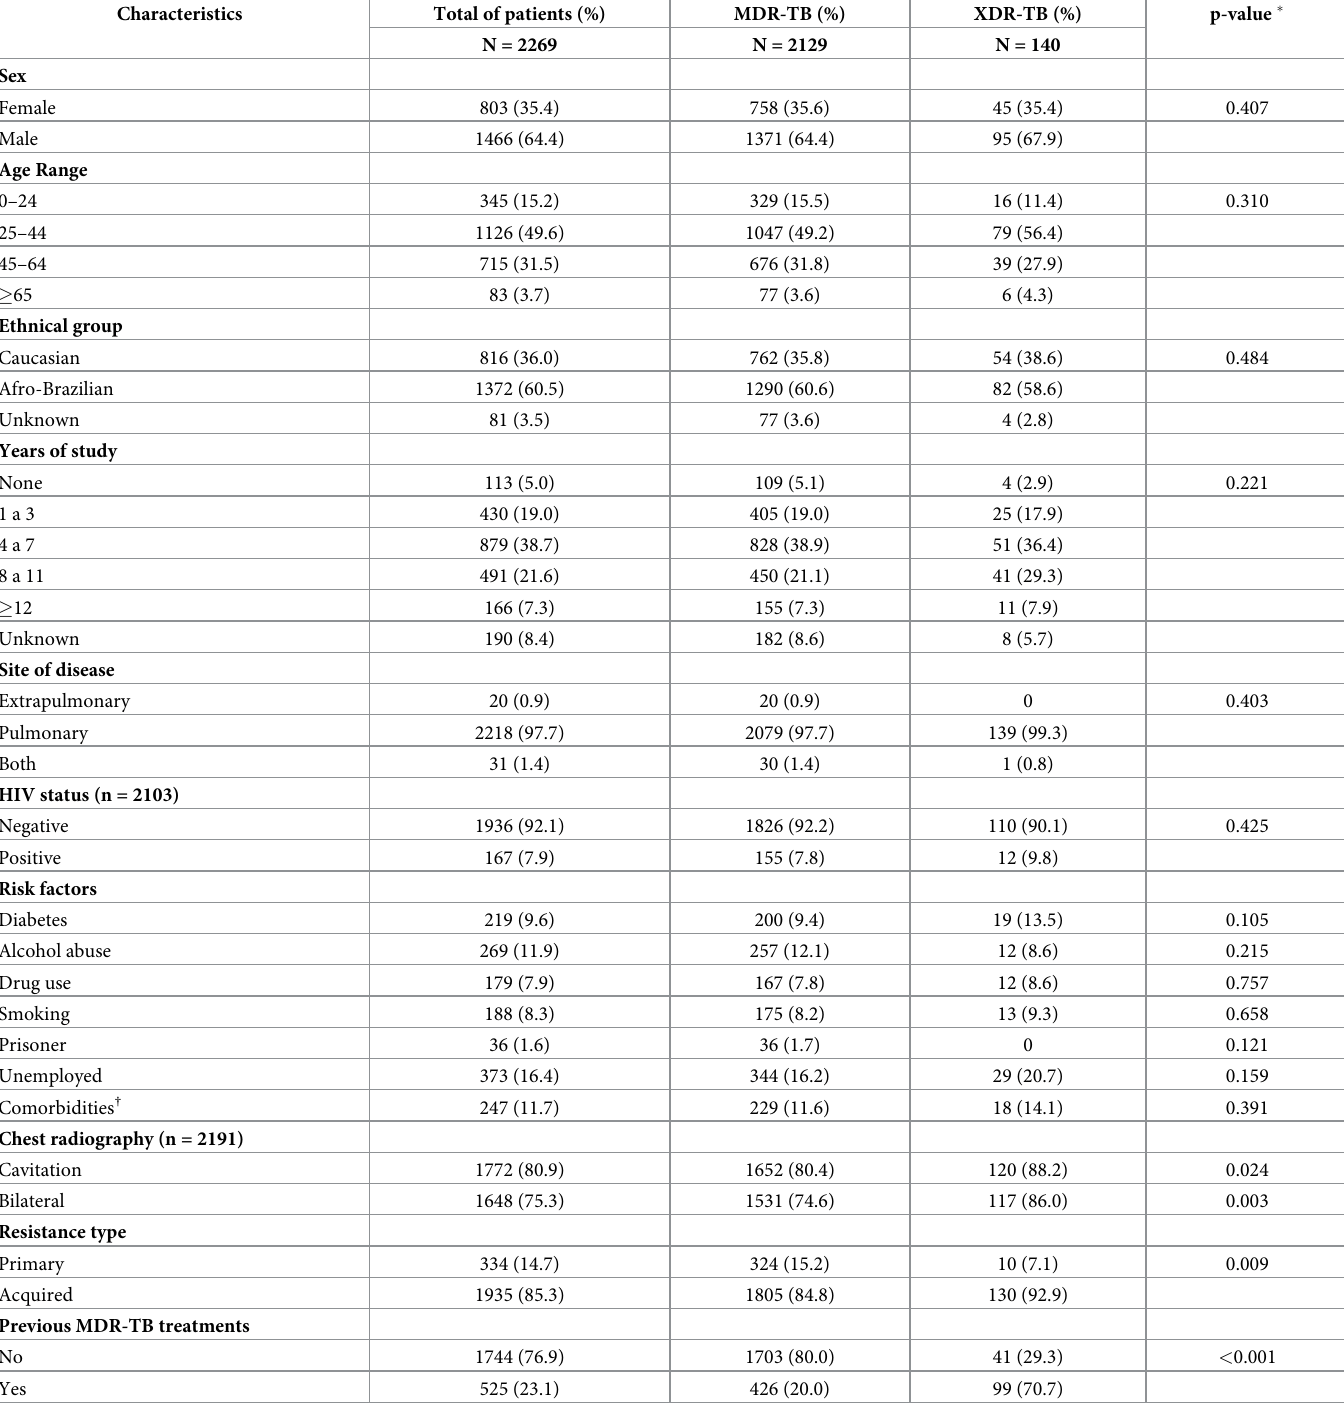
Table 1. Demographic and clinical characteristics of 2269 patients with MDR-TB and